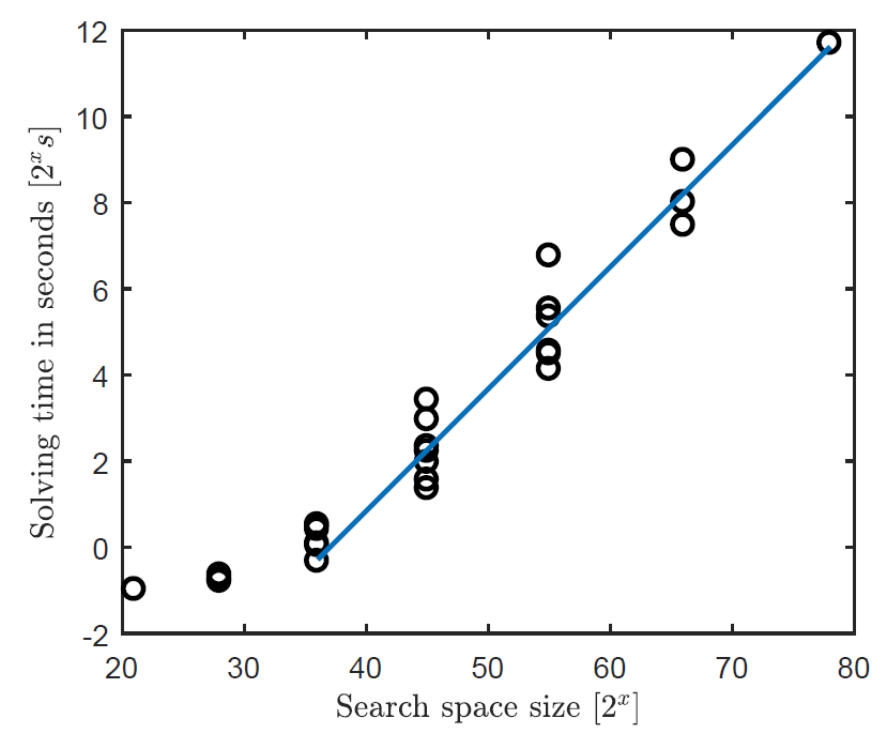
Figure 9. CSP solving time as a function of search space size. For the ease of reading: 2 12 s ≈ 68